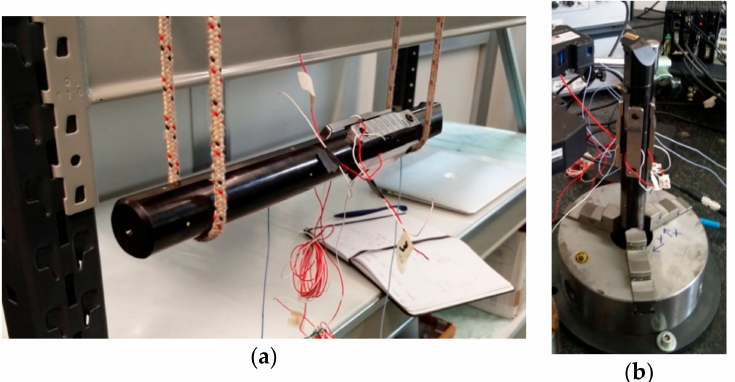
Figure 18. Setup for active boring bar experimental modal analysis. ( a ) Free-free condition. ( b ) Fixed- free condition.